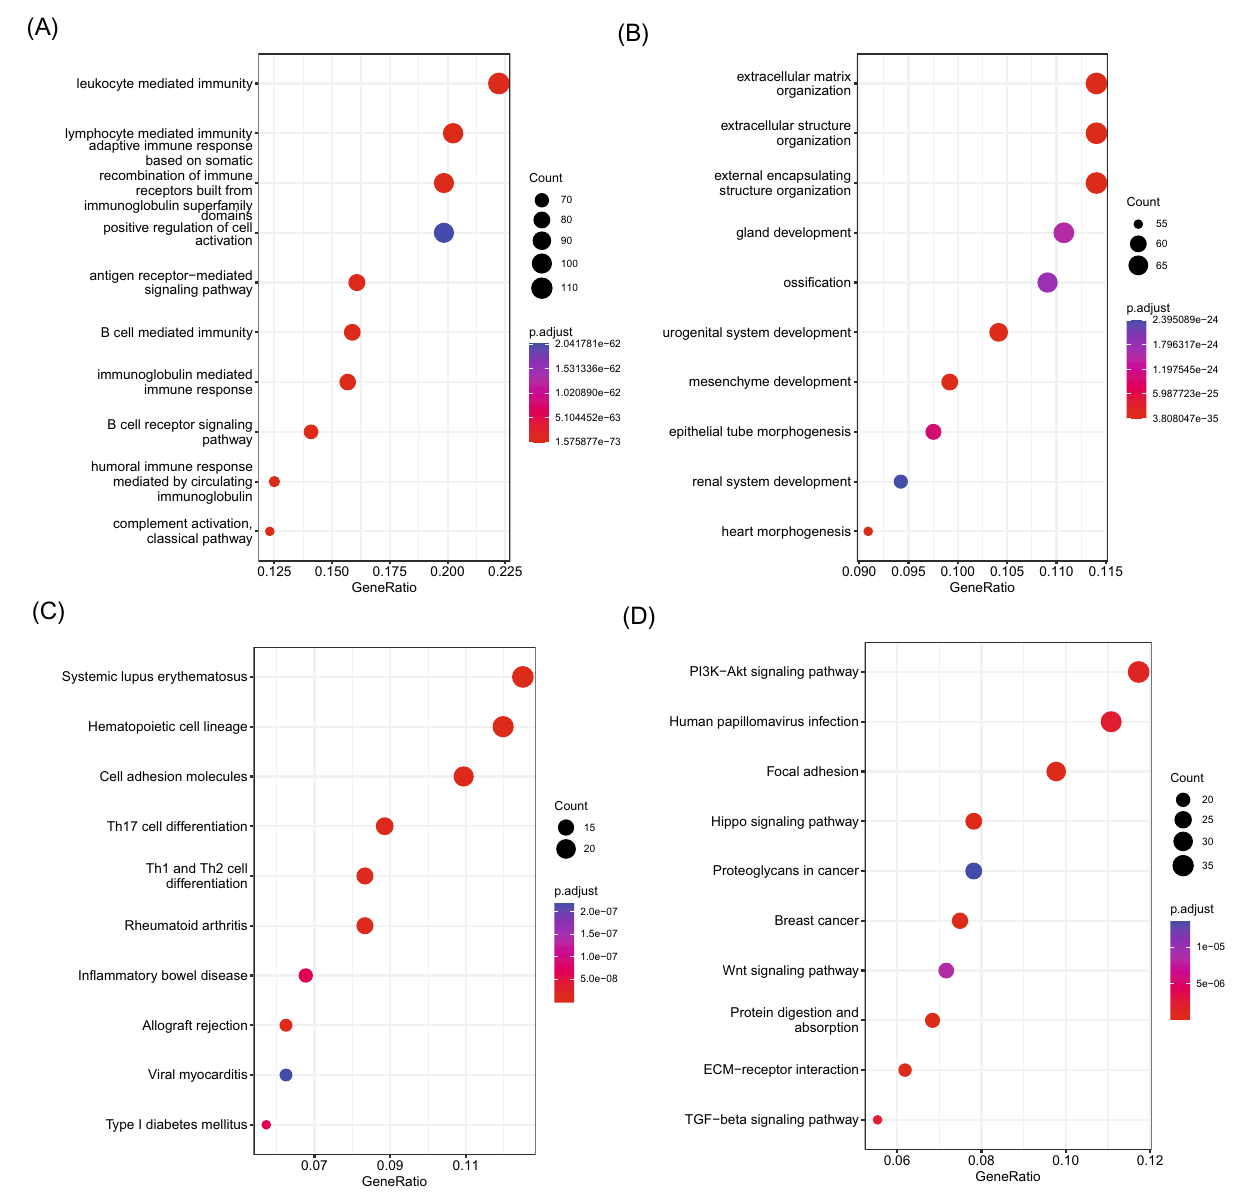
Figure 5. Functional enrichment analysis of the differentially expressed genes between high- and low-risk groups. ( A ) The top ten enriched GO terms of the upregulated genes with a higher gene count. ( B ) The top ten enriched GO terms pathways of the downregulated genes with a higher gene count. ( C ) The top ten enriched KEGG pathways of the upregulated genes with a higher gene count. ( D ) The top ten enriched KEGG pathways of the downregulated genes with a higher gene